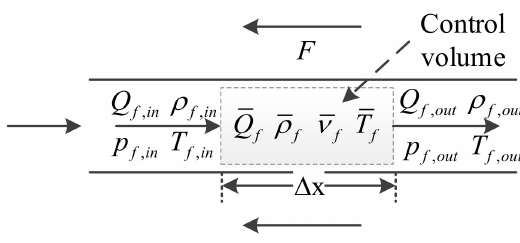
Figure 6. Control volume of the hydraulic